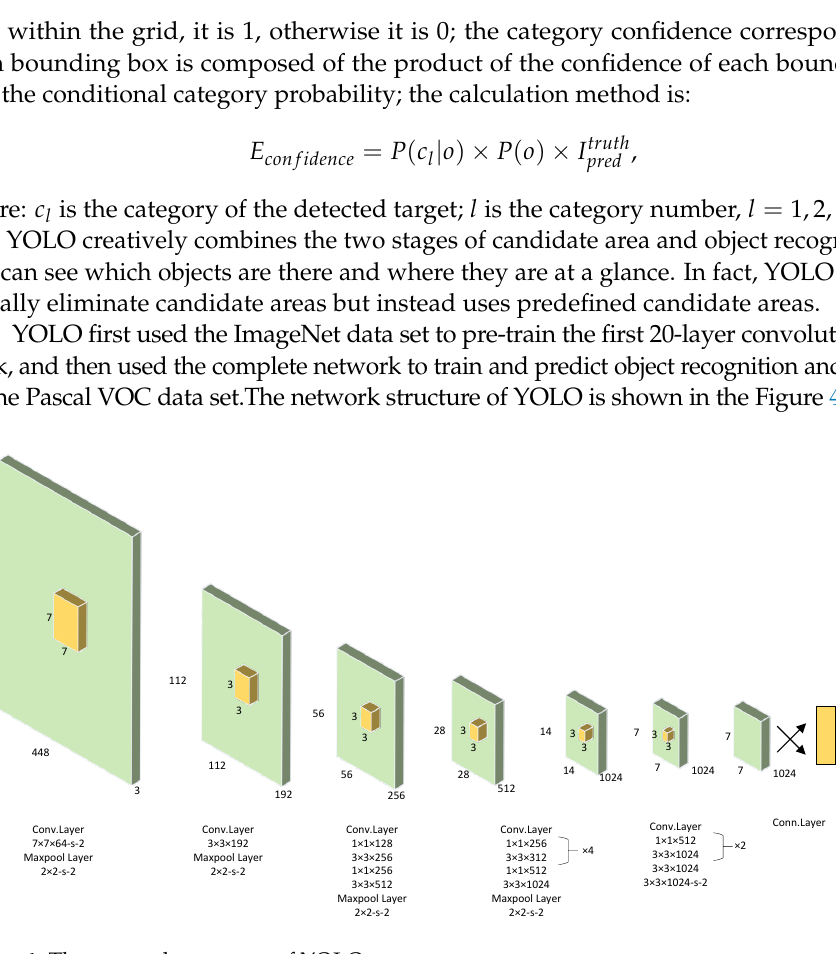
Figure 4. The network structure of